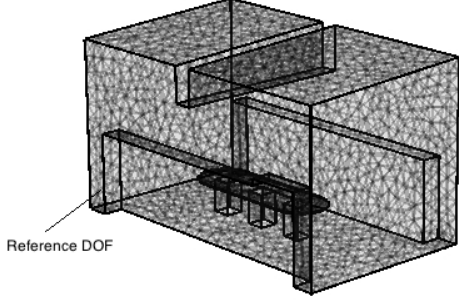
Fig. 3. COMSOL: FEM grid and reference microphone